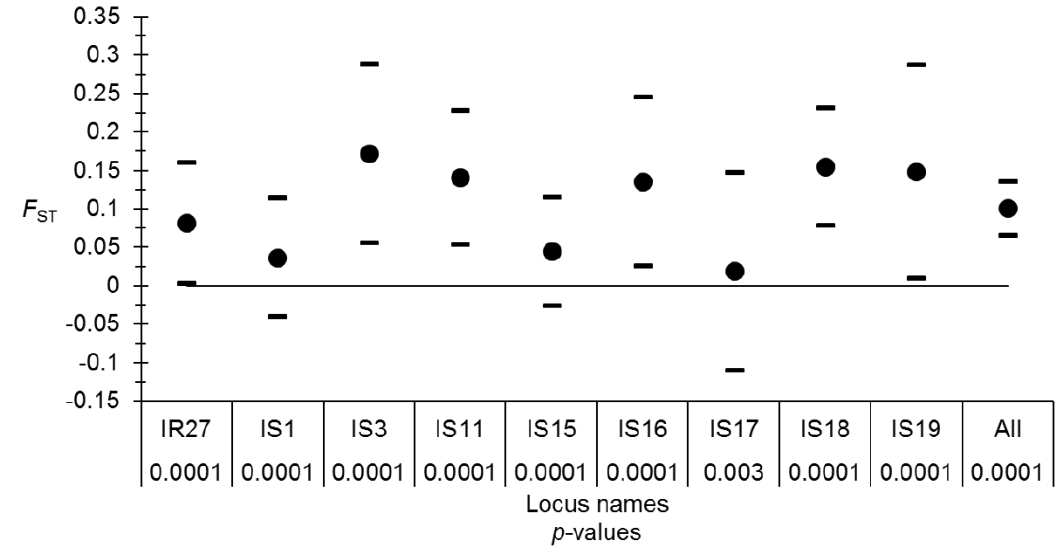
Figure 3. F ST values for each locus and averaged across those (All) of Ixodes scapularis from the eastern U.S.A. with 95% jackknife confidence intervals over subsamples (for each locus) and